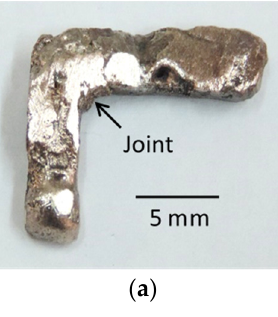
Figure 6. Experimental examples of scanning LMH–AM products: ( a ) An L-shape metal rod fabri- cated by two straight rods, each produced by scanning LMH–AM and joined together by a powder- batch LMH. ( b ) A metal object (~20 × 4 × 6 mm 3 ) made of 5 powder layers by scanning LMH–AM in five subsequent scans. This result demonstrates both the solidification capability of the scan- ning LMH–AM and the imperfections encountered in this process. These defects, including balling, cracking, and voids, are partly attributed to the fixed (non-adaptive) scanning velocity.